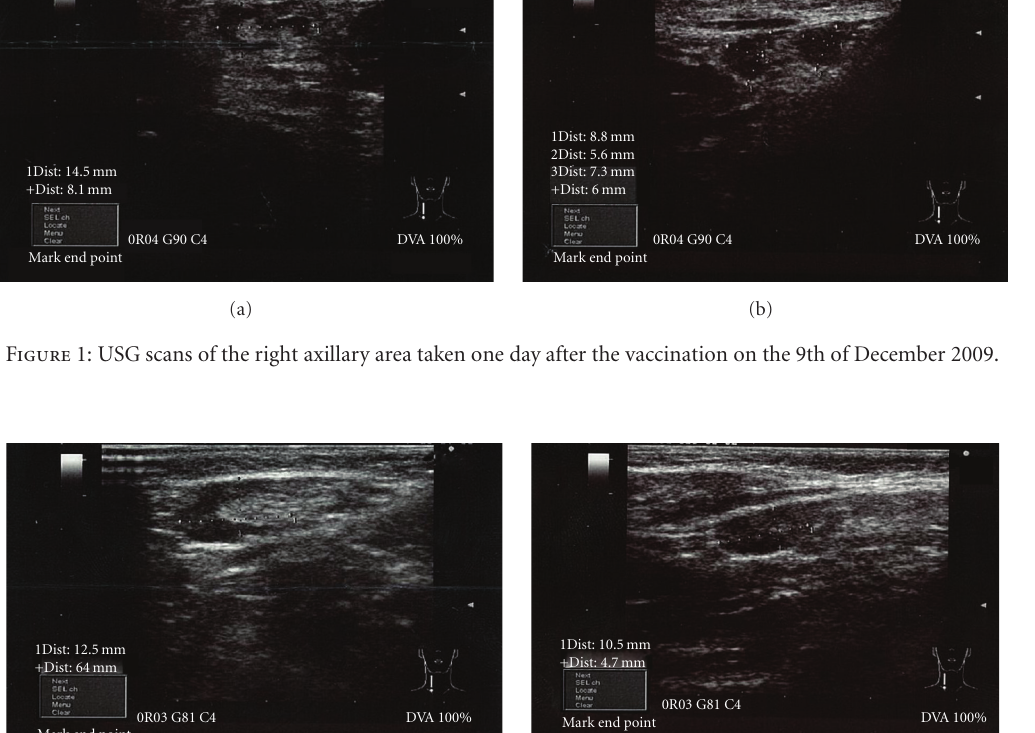
Ultrasound is a useful imaging modality in assessment of lymph nodes, and its features can help only in identifying abnormal nodes including size, shape, echogenic hilus, hypoechogenicity or isoechogenicity, echogeneity, coagula- tion necrosis, and a sharp nodal border